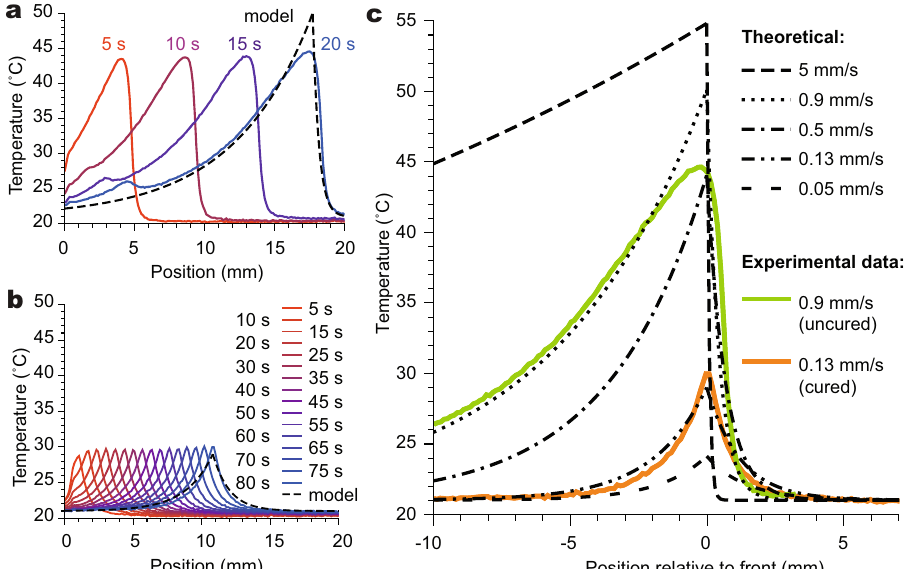
Fig. 3 Thermal pro fi les from sodium acetate trihydrate crystal growth through unpolymerized and polymerized samples. Temperature was monitored with an infrared camera. Solutions were crystallized on a cold plate set to a constant temperature in order to promote heat dissipation. Precursor solution composition for all samples: 7.0 M sodium acetate, 2.8 M acrylamide, 13 mM N,N ′ -methylenebisacrylamide, 2 mM α -ketoglutaric acid in water; 0.5 mm spacer. a and b Spatial temperature pro fi les at 5-s intervals resulting from growth of sodium acetate trihydrate crystals through aqueous solutions of unpolymerized ( a ) and polymerized ( b ) additives on a cold plate set to 20 °C. Dashed black lines show results of a global fi t of the fi nal curves in both graphs to an analytical model derived in Supplementary Information Section 4. See Supplementary Fig. 6 for similar pro fi les of samples suspended in air. c Plot of steady-state temperature pro fi les around crystal growth front using parameters from global fi t of data from a (green) and b (orange) to the model in Supplementary Information Section 4 shown for several